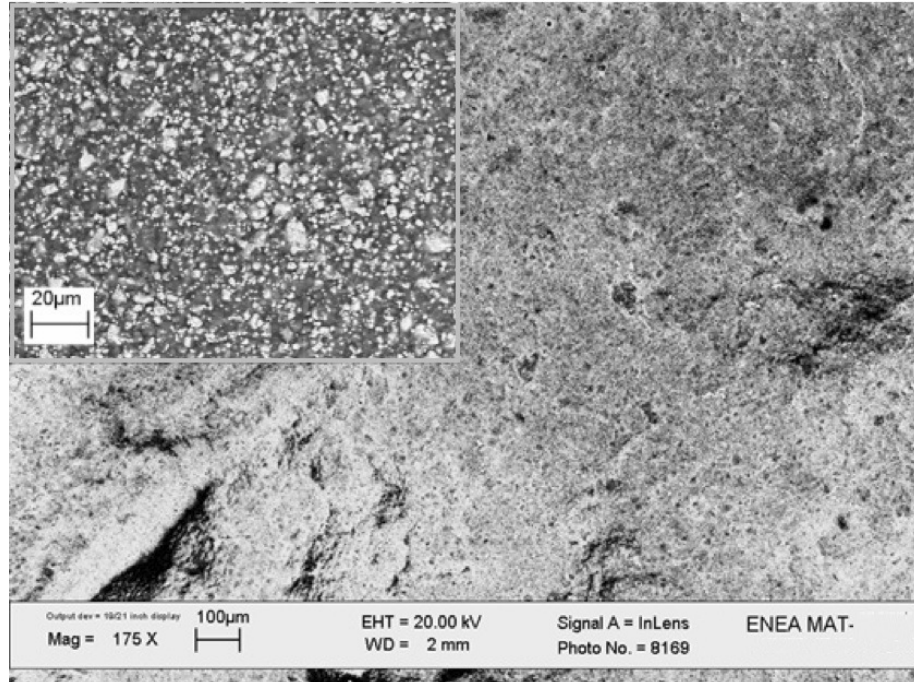
Figure 6. SEM image of the LaNi in the backscattered